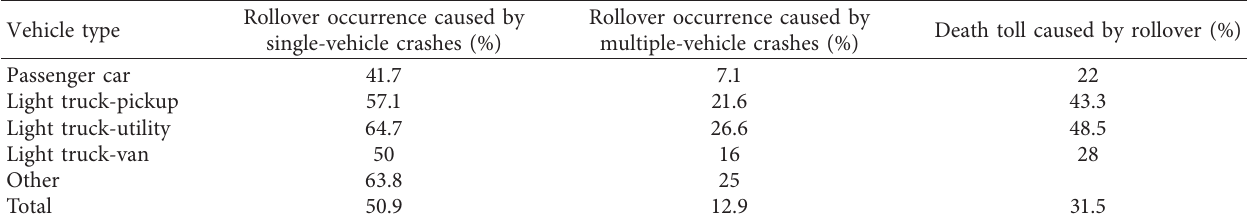
Table 1: United States Traffic Accident Statistics